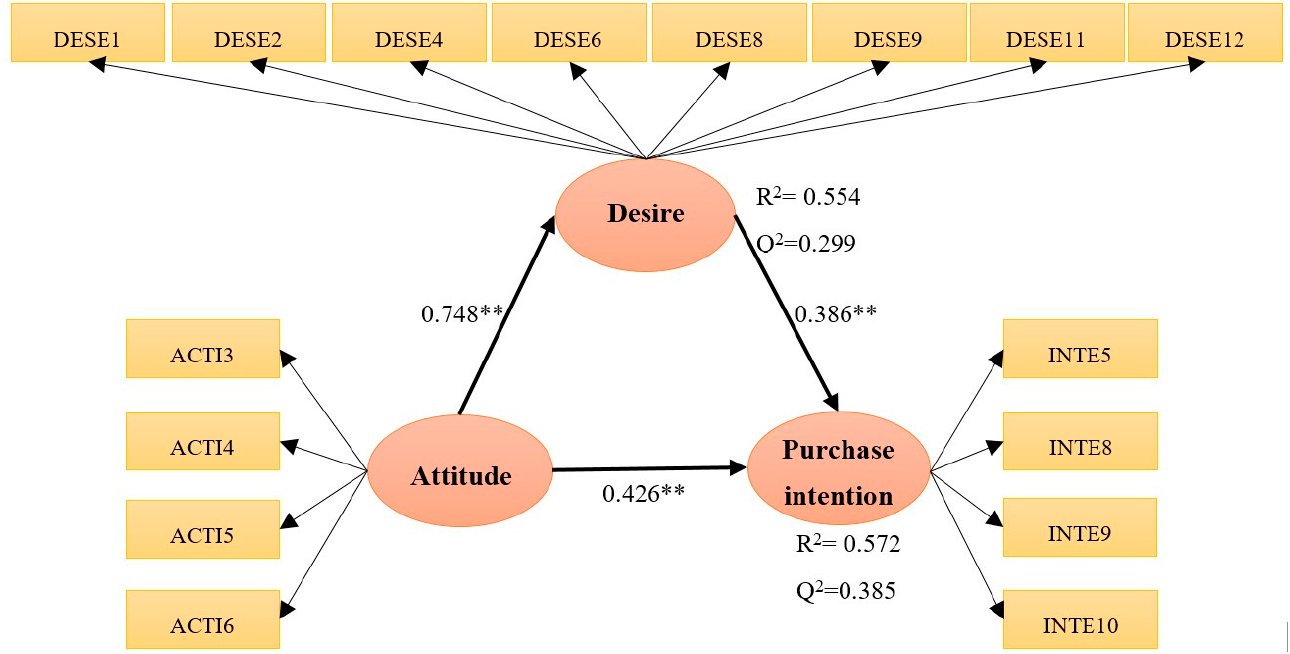
Figure 2. Determination coefficient and explanatory power of the hypothetical investigation model. ** p < 0.01. Table 5. Structural model assessment.